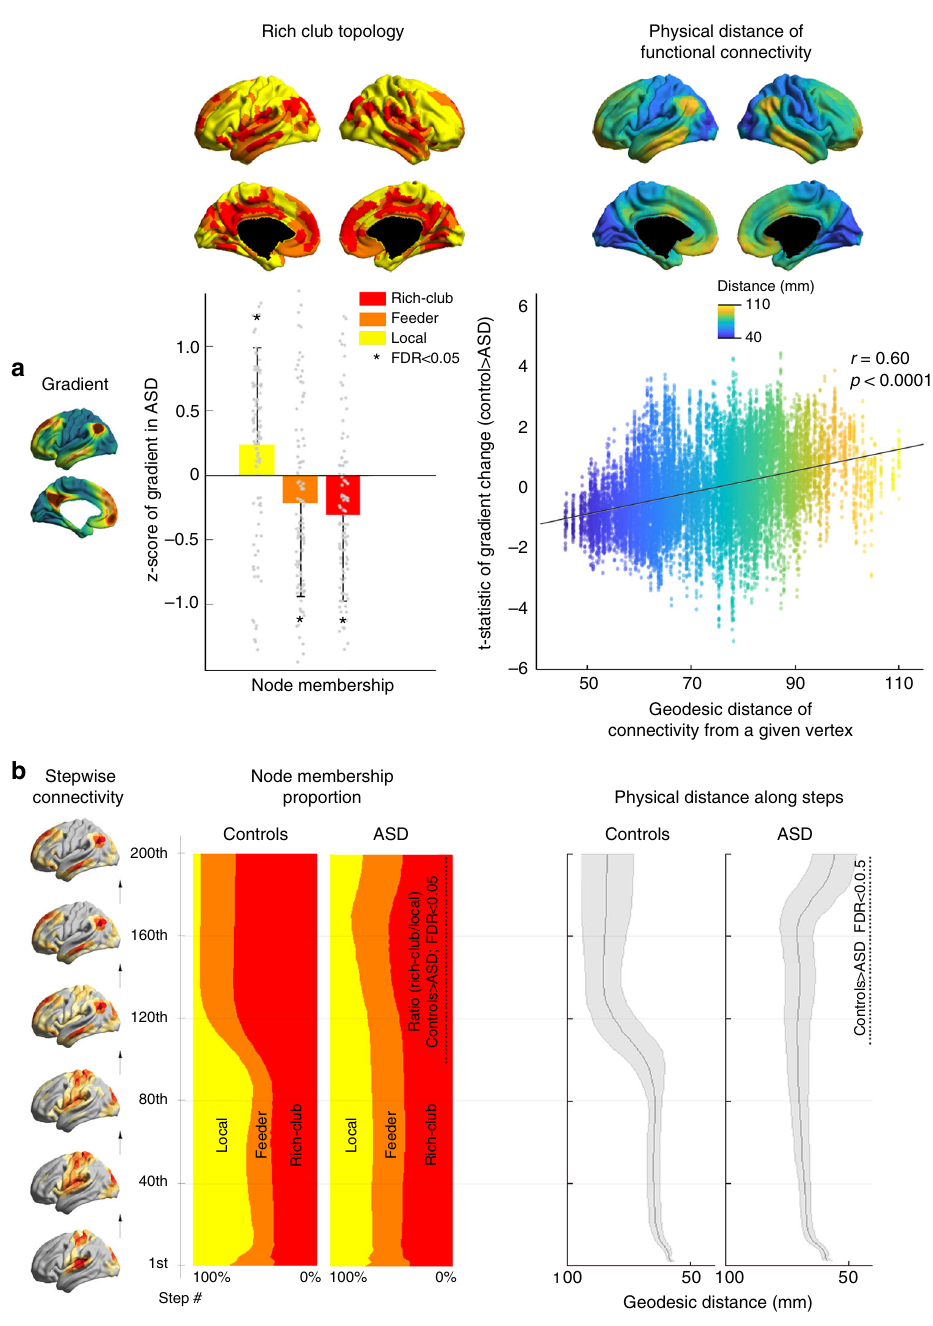
Fig. 4 Relationship to rich-club and physical distance of functional connections. The top left a illustrates the results of the gradient comparisons and rich- club taxonomy, showing gradient reductions in feeder and rich-club nodes in ASD compared to controls (based on Student ’ s t -tests) but increases in local nodes. The box plot indicates the mean ± SD. The top right a shows the vertex-wise association of between-group differences in gradient scores (t-statistic of the map from Fig. 1b; shown on the y -axis) and the average geodesic distance of functional connections of a given vertex ( x -axis). The positive association indicates that regions with long-range connections tend to show gradient reductions (Pearson correlation coef fi cient r = 0.6). The bottom left b panel shows the proportion of visited nodes as a function of SFC steps in controls and ASD, illustrating the lower proportion of active rich-club vs local nodes from 100 – 200 steps. The bottom right b shows signi fi cantly shorter average connectivity distances in autism at these higher steps, established using Student ’ s t -tests with multiple comparisons